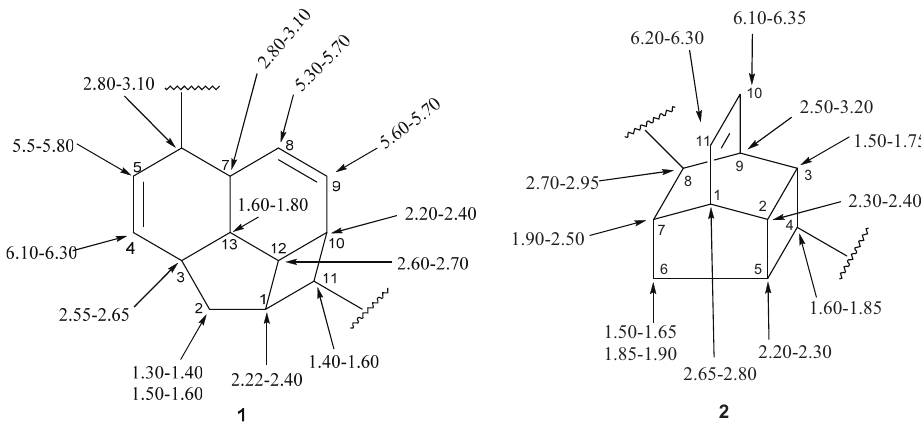
Figure 1. Range of 1 H-NMR chemical shift of tetracyclic endiandric acid (skeleton